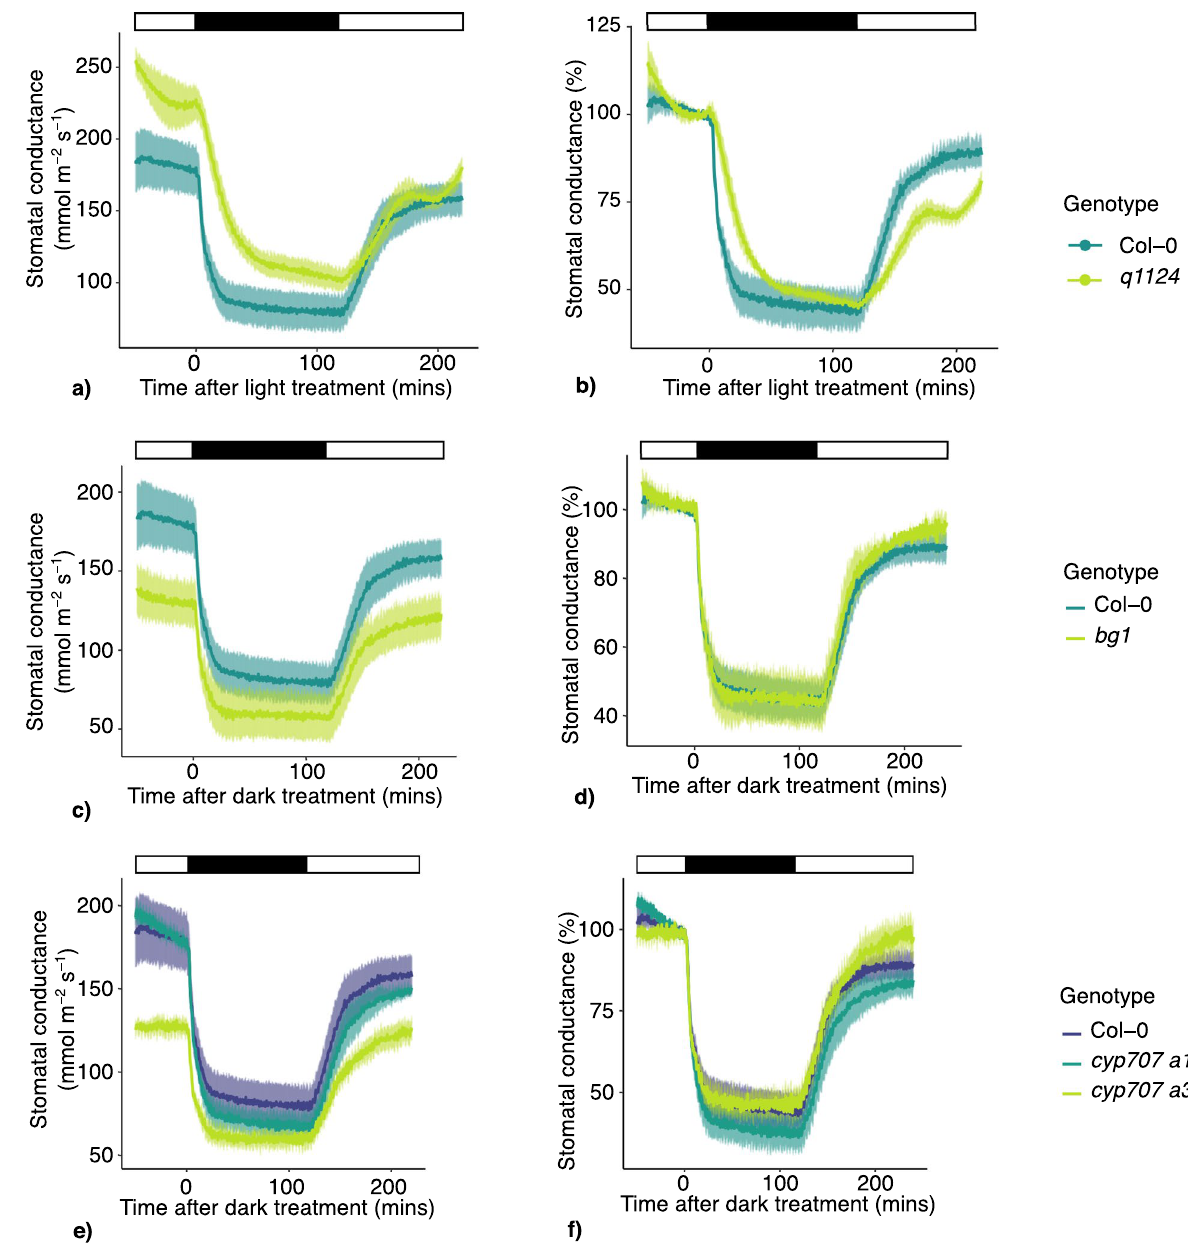
Figure 2. Stomatal conductance responses to darkness for ABA signalling, activation, and degradation mutants. Stomatal conductance of ABA signalling and metabolism mutants were measured in response to 120 mins darkness, followed by a further 120 mins light. Absolute and relative stomatal conductance values for ( a , b ) q1124 , ( c , d ) bg1 and ( e , f ) cyp707a1 and cyp707a3 are shown. Lines represent the mean ± s.e.m. 3–4 plants were measured per genotype. Light treatment is represented above each plot, with black boxes representing darkness and white boxes representing